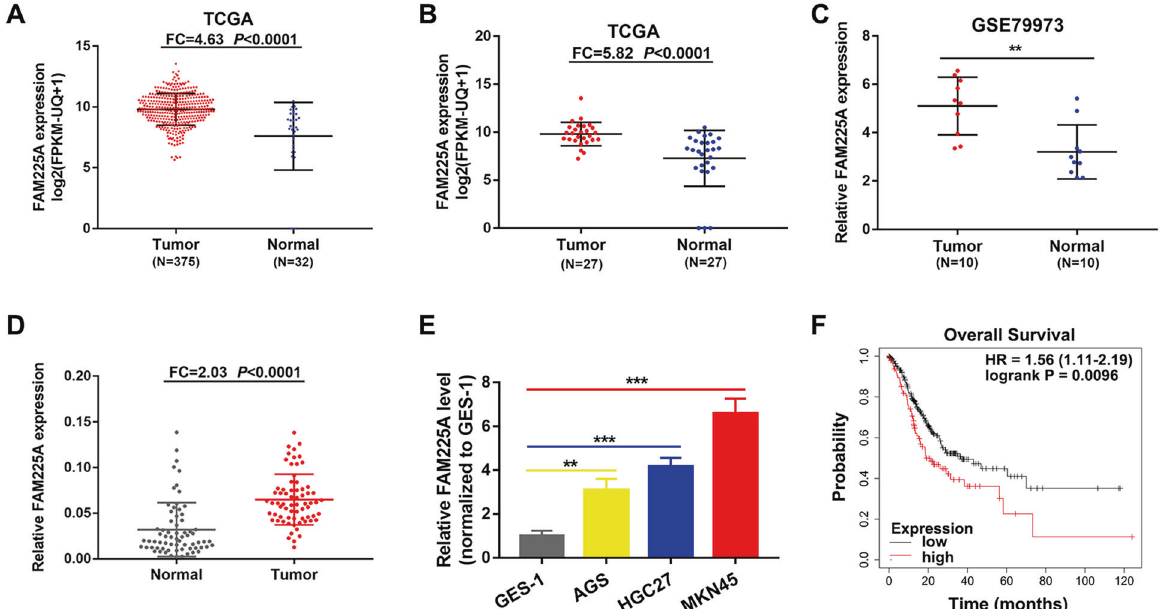
Fig. 1 FAM225A is upregulated in GC and predicts a poor prognosis. A , B Analyzing the expression of FAM225A in unpaired and paired GC tissues by using TCGA database. C Relative mRNA expression of FAM225A in GC tissues according to GEO database. D , E The expression of FAM225A was detected in our own 68 paired GC tissues, GC cells and GES-1. F Survival analysis of the association between FAM225A level and the overall survival (OS) rate of GC patients. p values were obtained by Student ’ s t test ( A – C , E ) or Wilcoxon test ( D ). FC fold change, ** p < 0.01, *** p <